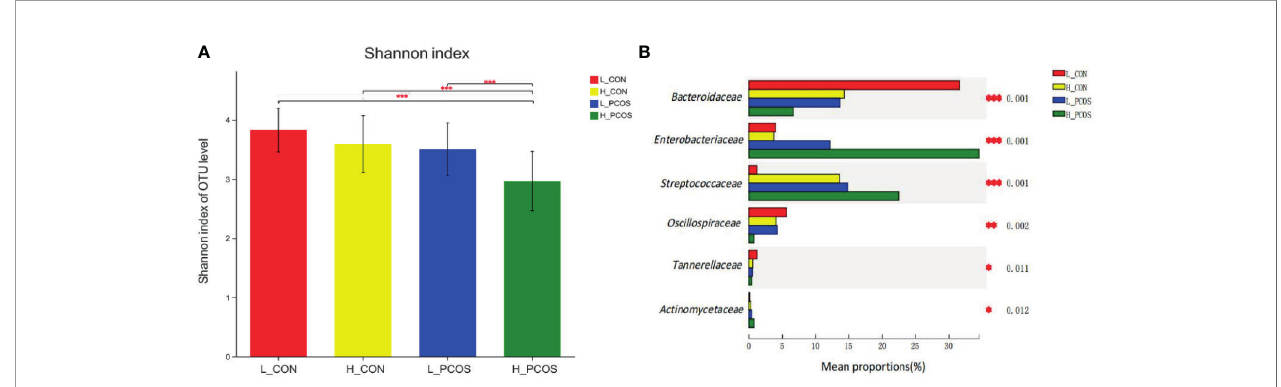
FIGURE 4 | Alpha diversity and Beta diversity of the gut microbial communities after adjustment for Age and BMI. (A) The Shannon index of OTU level showed the difference among the four groups. (B) Six groups of gut microbiota with statistical difference among the four groups were screened out. *P < 0.05, **P < 0.01, ***P <